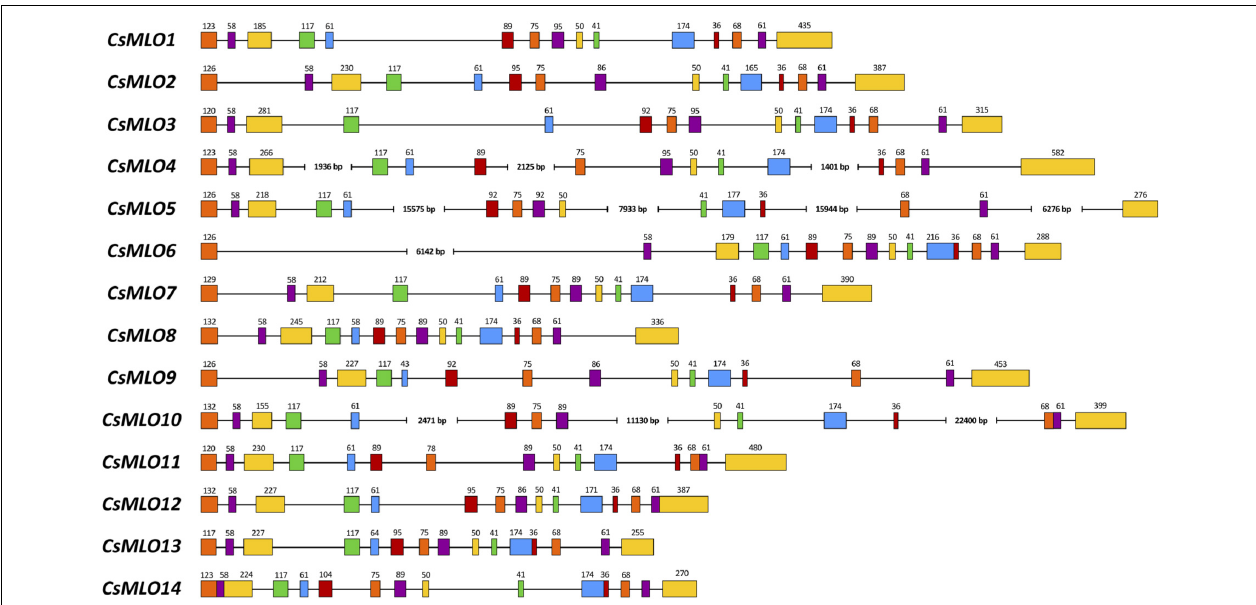
a CsMLO15-CBDRx is not predicted in the CBDRx genome, as compared to the other four genomes analyzed. b Number of transmembrane domains (TMs) in the predicted protein, as determined by the CCTOP online prediction server (Dobson et al., 2015). c Subcellular localization as predicted by three online prediction servers: Plant-mPLoc (Chou and Shen, 2010), YLoc-HighRes (Briesemeister et al., 2010), and DeepLoc 1.0 (Almagro Armenteros et al., 2017).